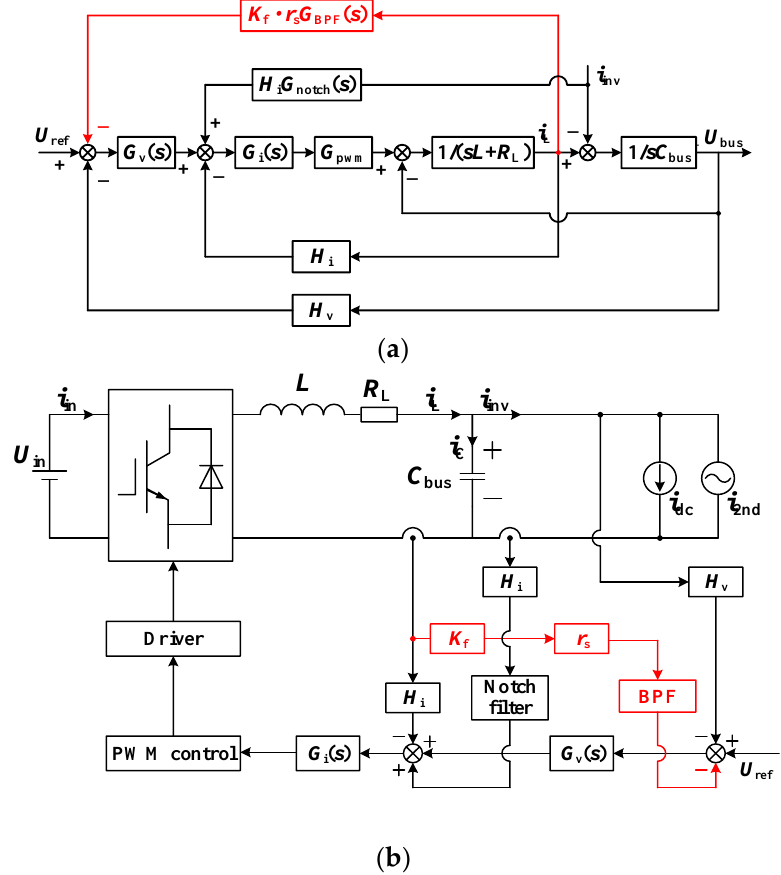
Figure 5. Proposed NICFPS. ( a ) Block diagram; ( b ) implementation.